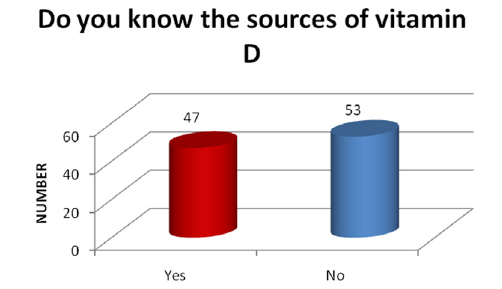
Fig. 2. Responses to question about knowing vitamin D